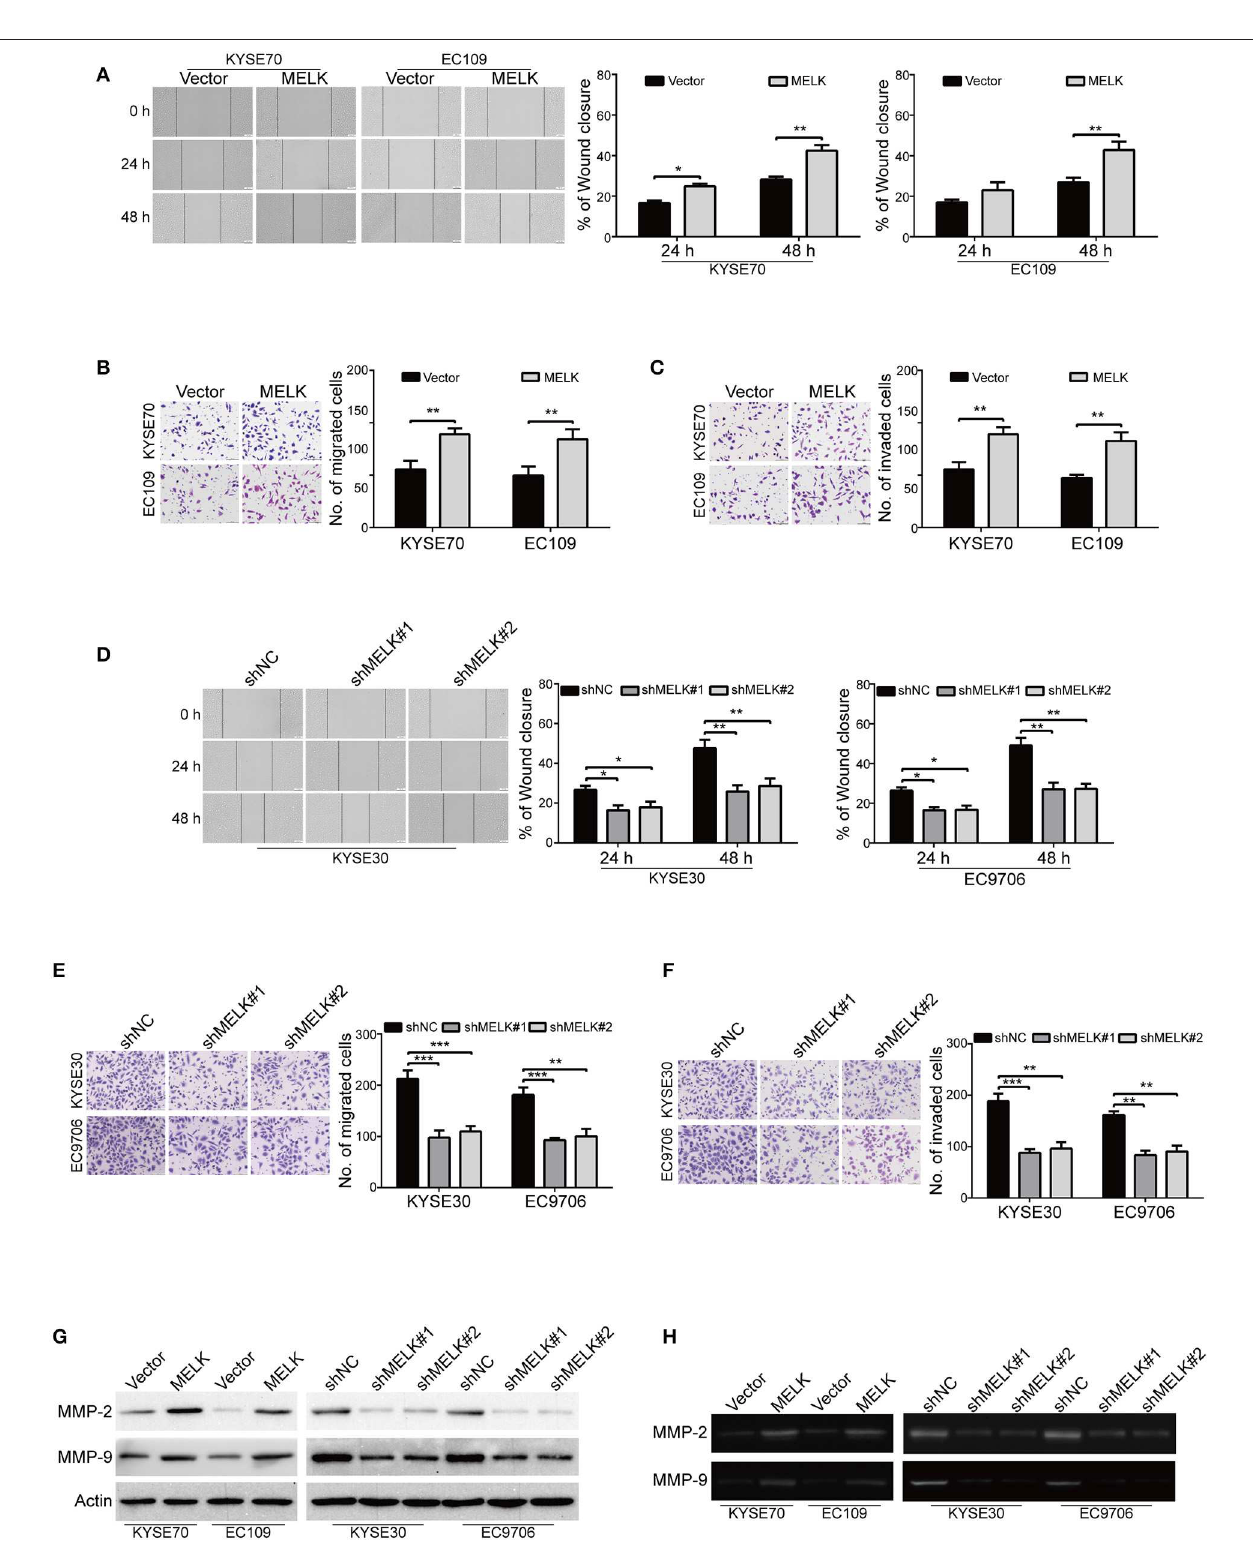
FIGURE 3 | MELK promotes the migration and invasion of ESCC cells. (A) Wound-healing assay was conducted to determine the effect of MELK on ESCC cell migration. Column and error bar represents mean ± SD ( n = 5 per group, right). (B,C) Representative images (left) and summary bar chart (right) of cells that migrated through a membrane (B) or invaded through a Matrigel-coated membrane (C) n = 5, Scale bars: 100 µ m. * P < 0.05 and ** P < 0.01 vs. Vector group; P -values were